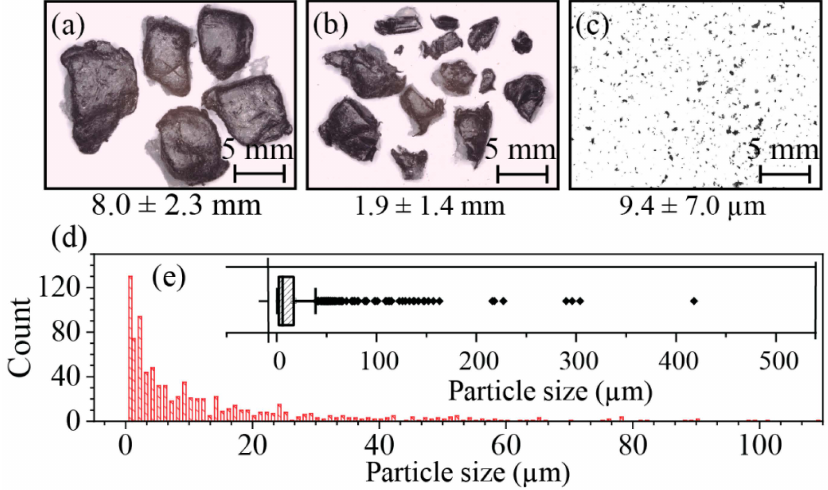
Figure 3. ( a – c ) the optical images of fining XLPE to powders for each process and ( d , e ) the final particle size